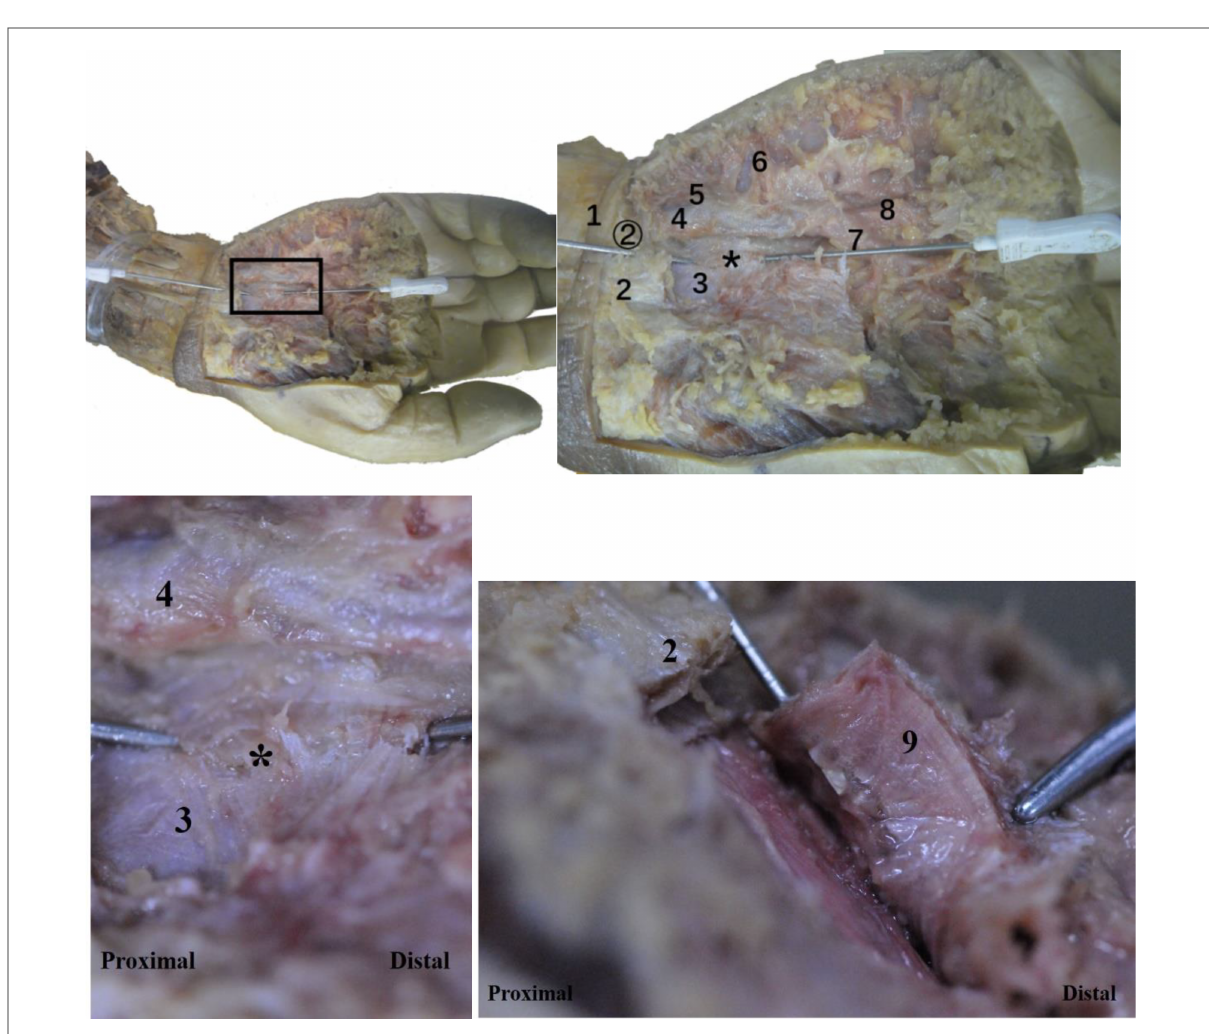
FIGURE 13 The vertical view (top left, top right) and side view (bottom left, bottom right) of the ultrasonic guided needle knife cutting trace. The asterisk refers to the cutting marks of the needle knife. 1. Proximal transverse carpal striae; 2. Palmar longus tendon connected to the palmar aponeurosis (cut); 3. Transverse carpal ligament; 4. Ulnar artery; 5. Ulnar nerve; 6. Super fi cial palmar branch of ulnar artery; 7. Palm Super fi cial arch; 8, common palmar artery; 9, transverse carpal ligament (turned up); ② , needle entry point